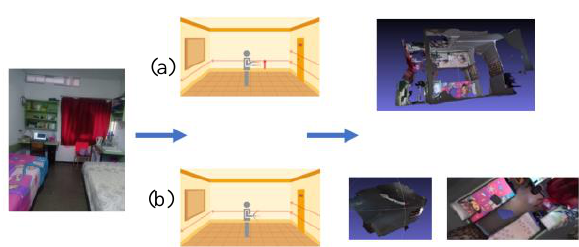
Figure 9. Result of the acquisition by translation (a) and by rotation (b) of the camera.